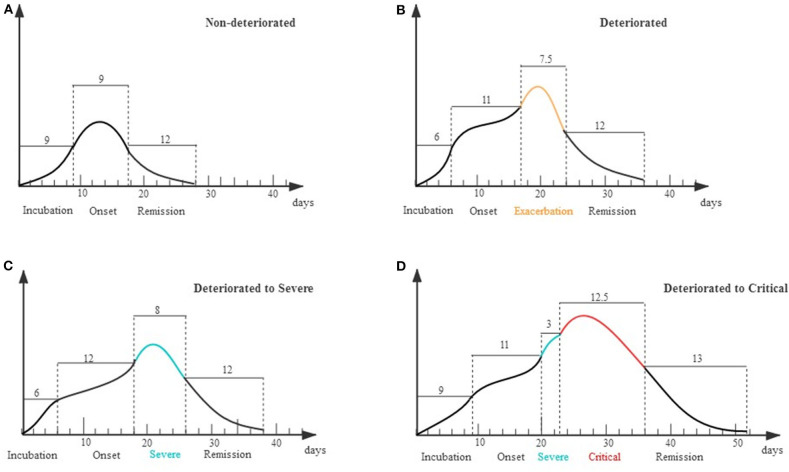
Schematic diagram for evolution of deterioration in moderate patients. X axis represents different stages of the clinical course that patients experienced; Y axis represents the severity of illness. (A) Non-deteriorated group. Patients typically had a 9-day disease incubation period [median, interquartile range (IQR) 5–13, n = 633] and a 9-day onset stage (IQR 7–12, n = 1,020) before entering a 12-day remission stage (IQR 9–17, n = 1,020). (B) Deteriorated group. Patients typically had a 6-day disease incubation period (IQR 4–10, n = 115) and an 11-day onset stage (IQR 9–14, n = 148) before deteriorating and entering an exacerbation stage of 7.5 days (IQR 4–12, n = 144). (C) Deteriorated to Severe. Patients had a 12-day onset stage (IQR 9–14, n = 130) before deteriorating to an 8-day exacerbation stage (IQR 4–12, n = 130). (D) Deteriorated to Critical. Patients deteriorated to a 3-day severe stage (IQR 2–6.5, n = 14) on the 11th day (IQR 8–12) from illness onset and further stepped into critical stage (IQR 6.75–25.75, n = 18).